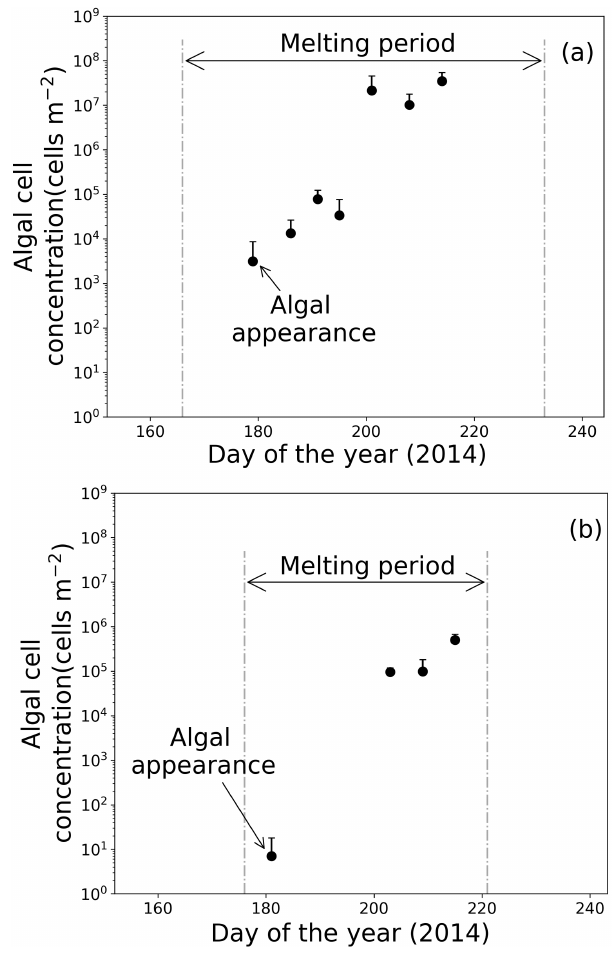
Figure 6. Temporal changes in algal abundance on snow surface at (a) Site A and (b) Site B. Melt periods in (a) and (b) are indicated in Figs. 3b and 4b. Standard deviation shown by error